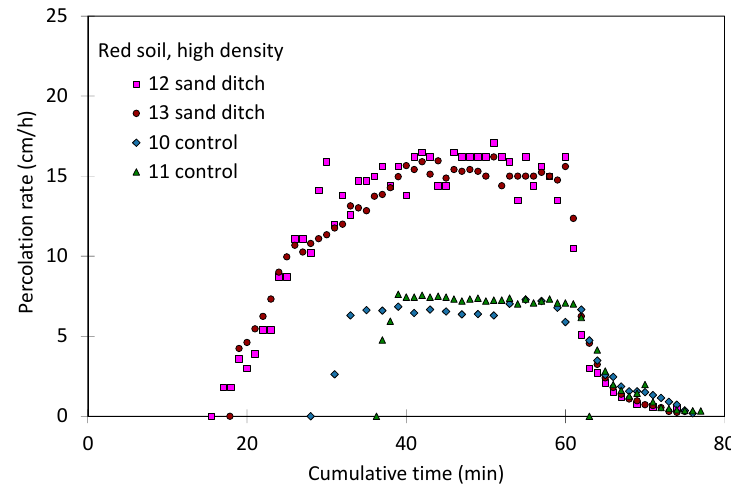
Figure 6. Percolated water rates of soil boxes for compacted high-density clay soil.